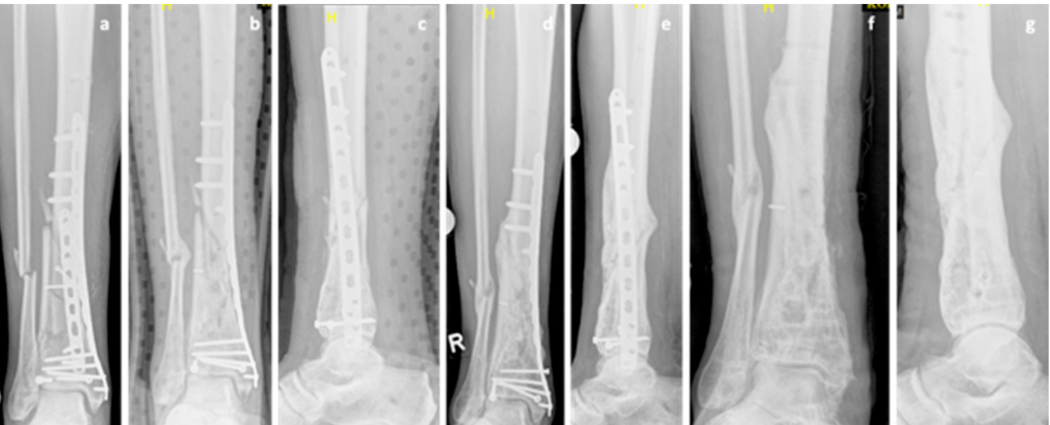
Figure 5. Case 5, x-rays showing the postoperative outcome after initial treatment of grade 1 open tibial and fibular fracture ( a ), after partial hardware removal (anterior tibial plate) and autologous cancellous bone grafting at the presence of an atrophic tibia nonunion 9 months after trauma ( b , c ) and after achieving bone union 18 months after the initial injury ( d , e ). Final result after hardware removal 24 months after trauma ( f , g